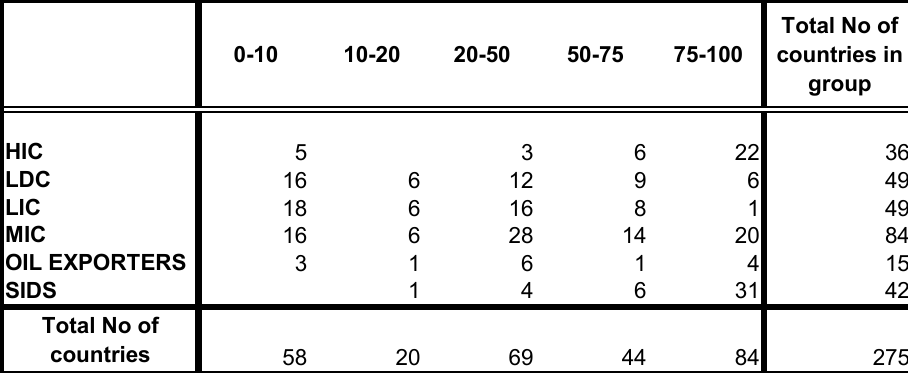
HIC-High income countries, MIC-middle income countries, LIC-low income countries,(World Bank defi- nitions), SIDS=small island developing states, LDC-least developed countries (UN definitions). Some countries in the LDC, Oil exporter and SIDs groups are included in the other categories as well. Source. Author’s computations from FAO